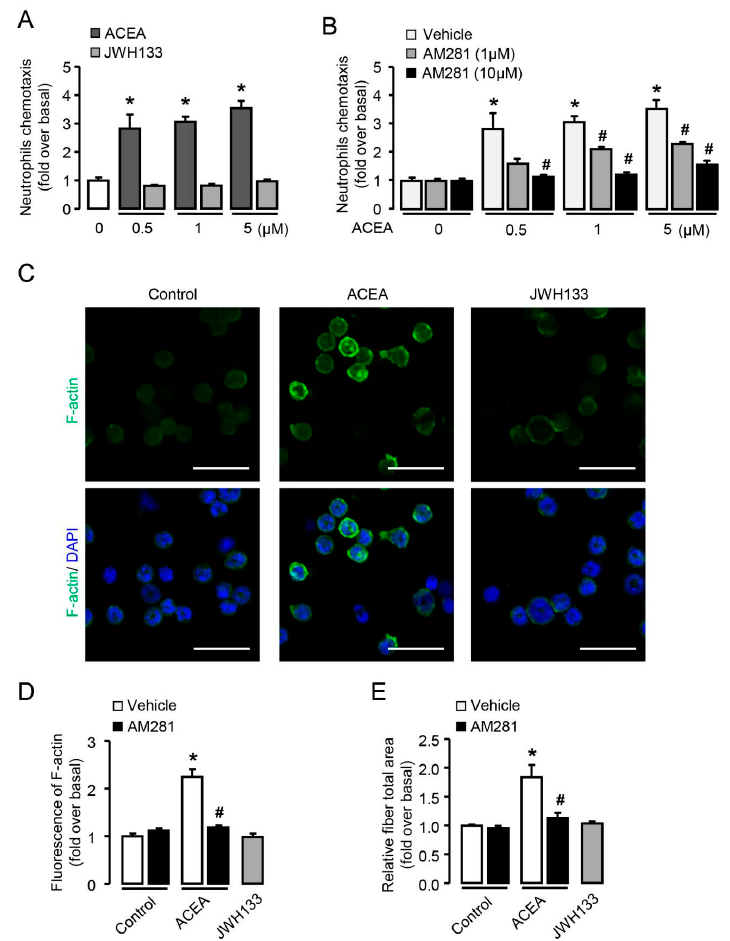
Figure 3. CB1 rather than CB2 mediates the chemotaxis and cytoskeletal remodeling of neutrophils in vitro. Chemotaxis assays were performed by transwell chambers. ( A ) Neutrophil chemotaxis with ACEA (CB1 agonist) or JWH133 (CB2 agonist) treatment for 2 h. ( B ) Effect of AM281 (CB1 antagonist) on neutrophil chemotaxis. ( C ) Representative images of F-actin remodeling with ACEA (1 µM, 2 h) and JWH 133 (1 µM, 2 h) treatment in neutrophils. Scale bars, 20 µm. ( D ) Quantification of F-actin with or without AM281 (10 µM) in ACEA-treated neutrophils. ( E ) The total fiber area was qualified by high content analysis in ACEA-treated neutrophils with or without AM281 pretreatment. Data are presented as the mean ± SEM. N = 5 per group. * P < 0.05 vs. control. # P < 0.05 vs. ACEA-treated alone.